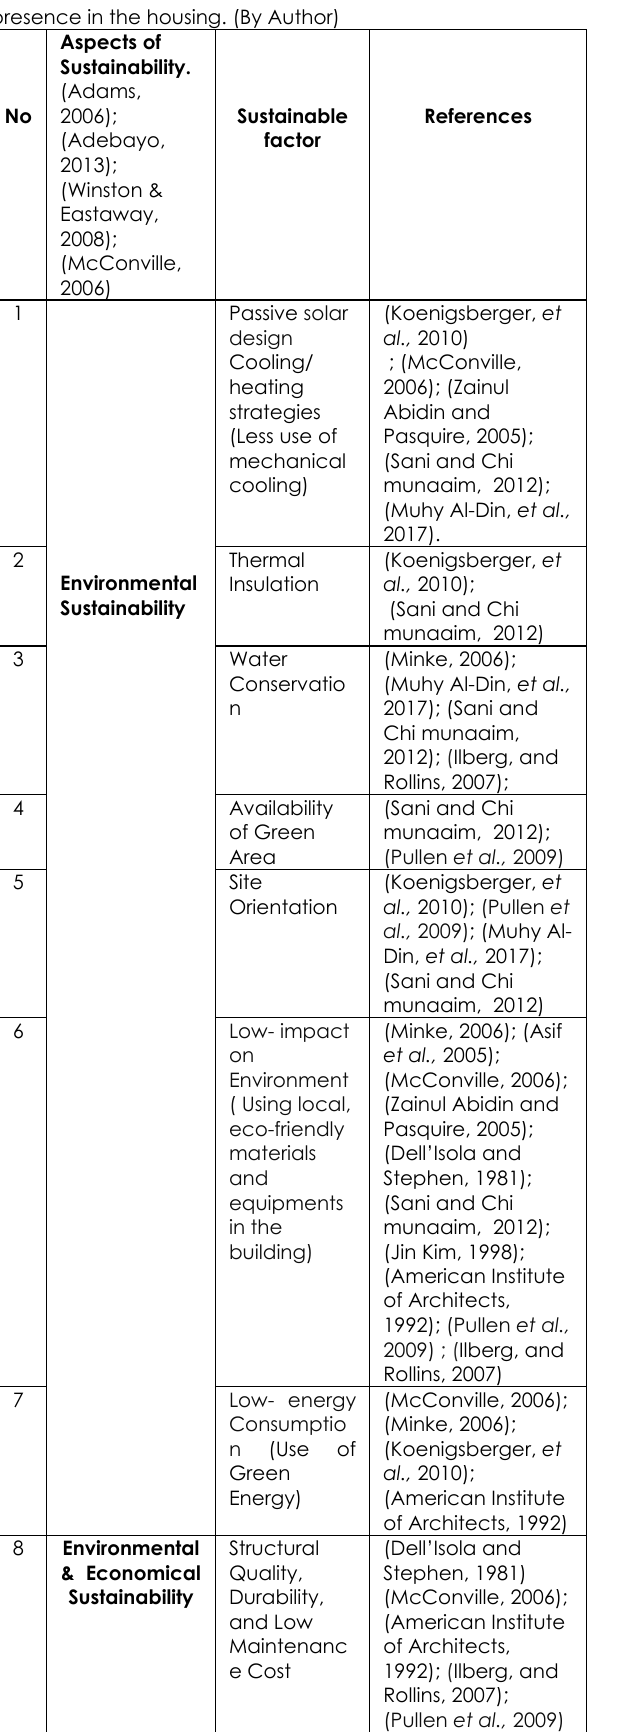
Table 3. The assessment checklist for sustainable factor presence in the housing. (By Author) Aspects of No